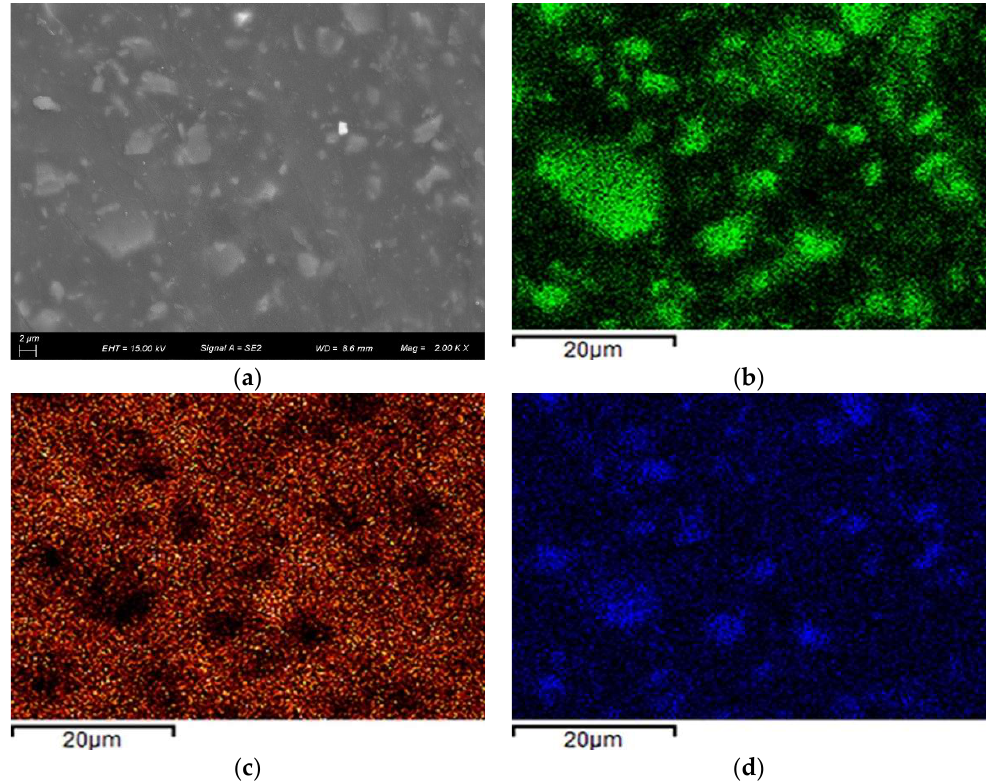
Figure 7. SEM micrographs and elemental mapping of coating films with the addition of ATH. ( a ) SEM image of formulation H-0.75; ( b ) Aluminum map; ( c ) Carbon map; ( d ) Oxygen map.